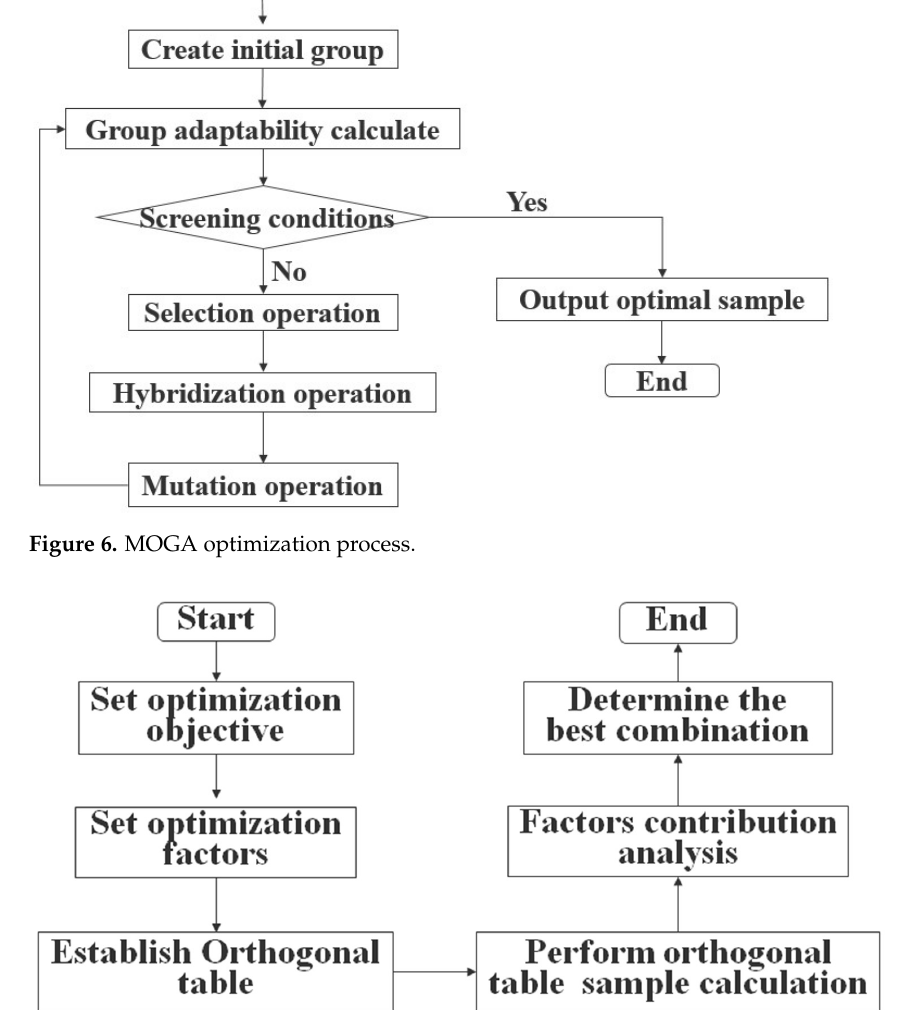
Figure 7. Taguchi method optimization process.